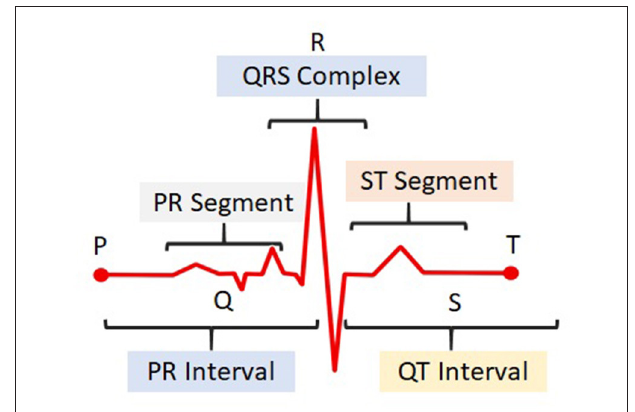
FIGURE 2 | A typical ECG signal and the various waves, segments, and